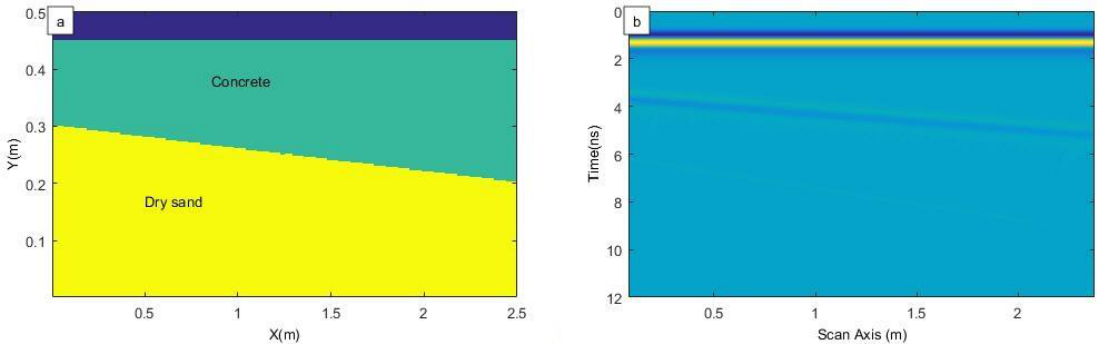
Figure 10. Simulation model of GPR: ( a ) forward geometry model; and, ( b ) simulation signal of GPR.